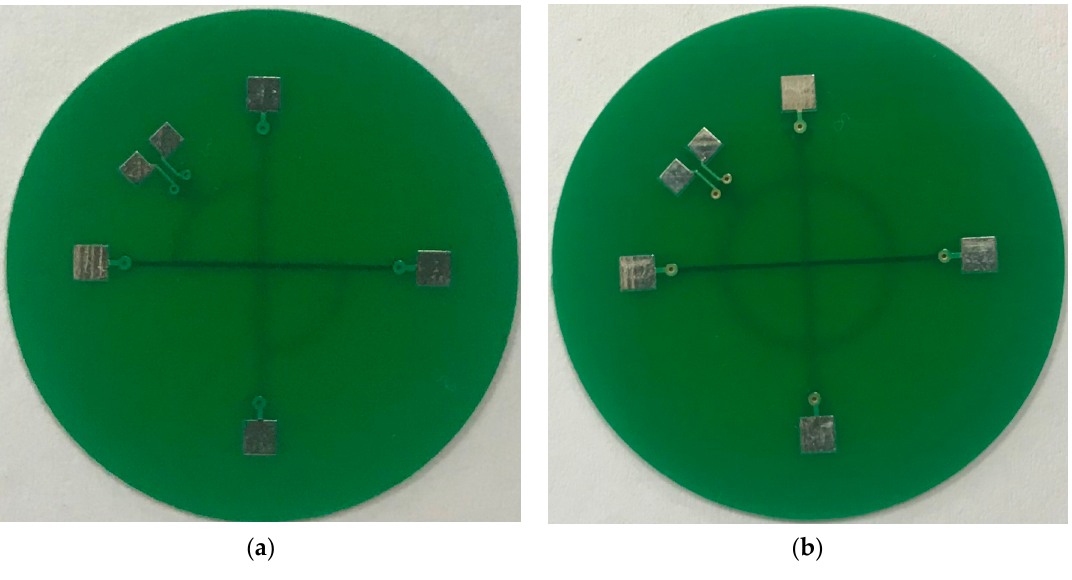
Figure 3. The two kinds of probes: ( a ) probe A, ( b ) probe B.